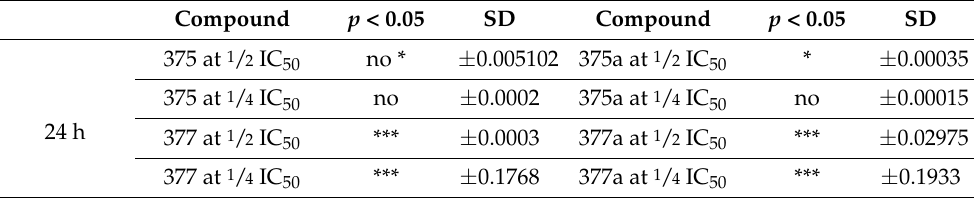
Figure 1. Changes in proliferation status of Ishikawa endometrial cancer cells after 24- and 72-h incubation with 375 (rhenium aspirin), 375a (aspirin), 377 (rhenium indomethacin) and 377a (indomethacin) at IC 50 concentrations ( a ). The assay was performed using the BrdU proliferation kit (Biovision). Cisplatin (CisPt) was used as a positive control ( b ). Data were obtained by measuring absorbance at 450 nm in three independent experiments. Results were statistically compared with the negative control (untreated cells with 1% DMSO dissolved in cell culture medium) using a Two-way ANOVA with Bonferroni multiple comparison test; * = p < 0.05, ** = p < 0.01, *** = p < 0.001. Table 3. Effect of 375 , 375a , 377 , and 377a at IC 50 , ½ IC 50 , and ¼ IC 50 concentrations on Ishikawa cells proliferation. Results are presented for 24- and 72-h incubation periods. One-way ANOVA with Bonferroni’s comparison test was chosen for statistical analysis.